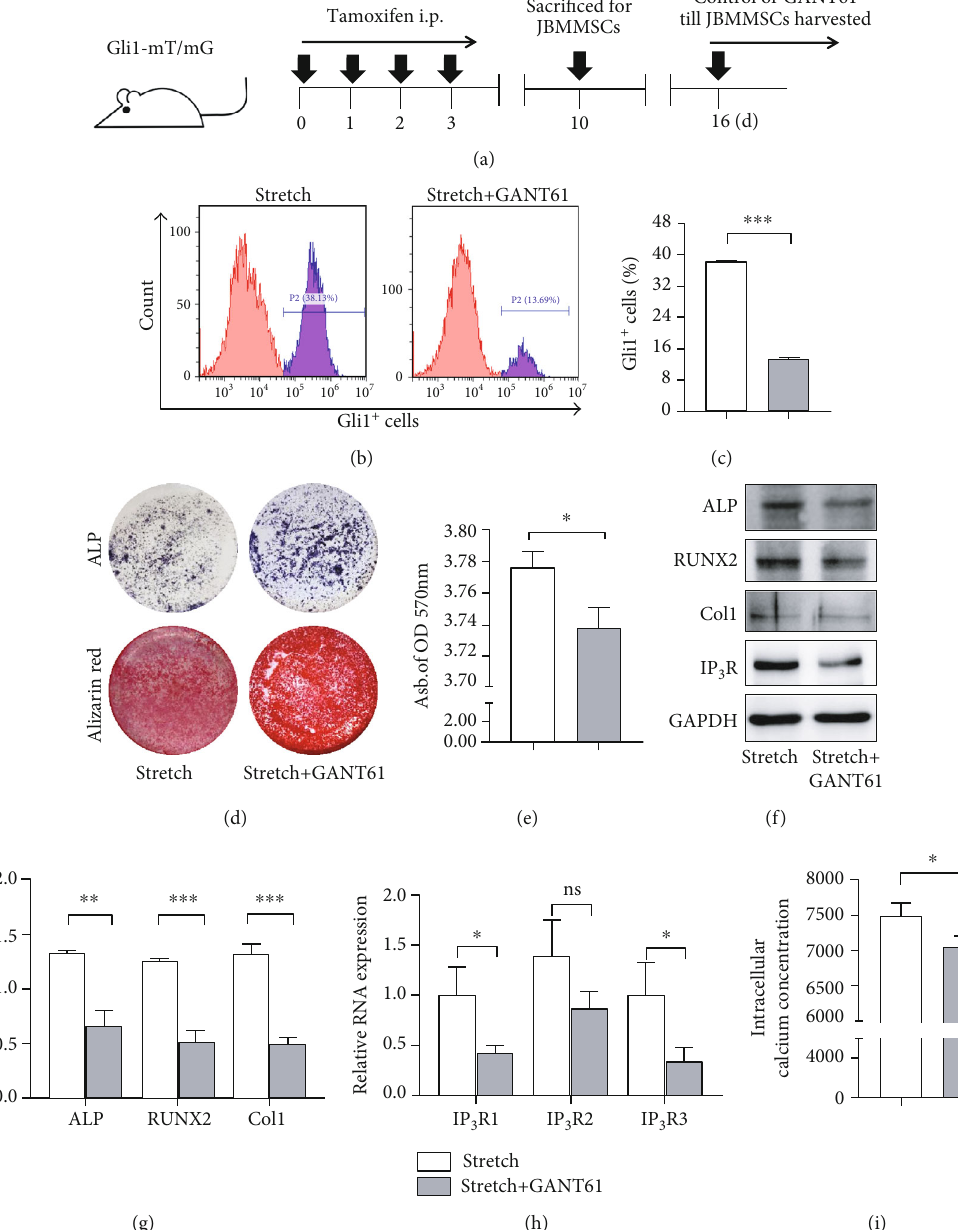
Figure 5: Gli1 + cells participate in mechanical force-mediated JBMMSC osteogenesis through an IP R-induced intracellular calcium 3 concentration increase. (a) Experimental procedure: Gli1-mT/mG mice were treated with tamoxifen for 4 consecutive days and were sacri fi ced after 7 days to isolate JBMMSCs. After 6 days of incubation, cells were treated with GANT61 (stretch+GANT61) or vehicle (stretch). (b) Flow cytometry analysis of the proportion of Gli1 + cells in JBMMSCs showed a decrease of Gli1 + cells in the GANT61- treatment; n = 3 . (c) The proportion of Gli1 + cells was lower in the stretch+GANT61 group; ∗∗∗ P < 0 : 005 ; n = 3 . (d) ALP activity of JBMMSCs treated with GANT61 was reduced after osteogenic induction for 7 days. Mineralized nodules formed by JBMMSCs were detected using alizarin red staining after osteogenic induction for 14 days. (e) The abundance of mineralized nodules in the